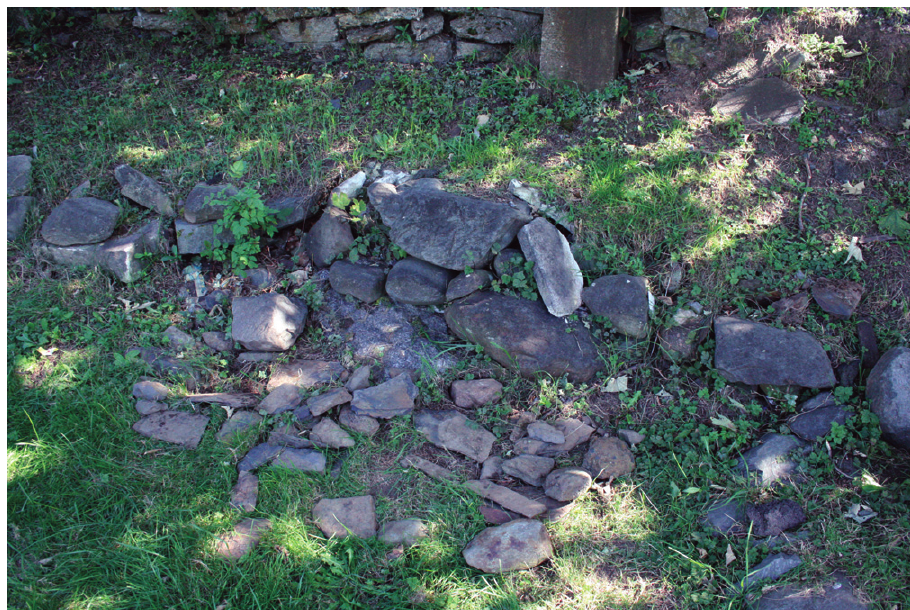
Figure 5. Th e collection locale of the Phosphaenus hemipterus larvae in the Holy Cross site in a rock pile. Note the rock wall in the background. Photo credit: Christopher Majka.